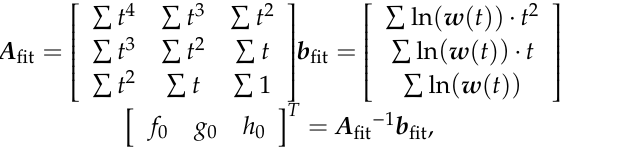
Figure 11. ( a ) Mean curves and ( b ) variance curves of the four bathymetric points. The time offset indicates the offset of the waveform from the peak of the surface signal.